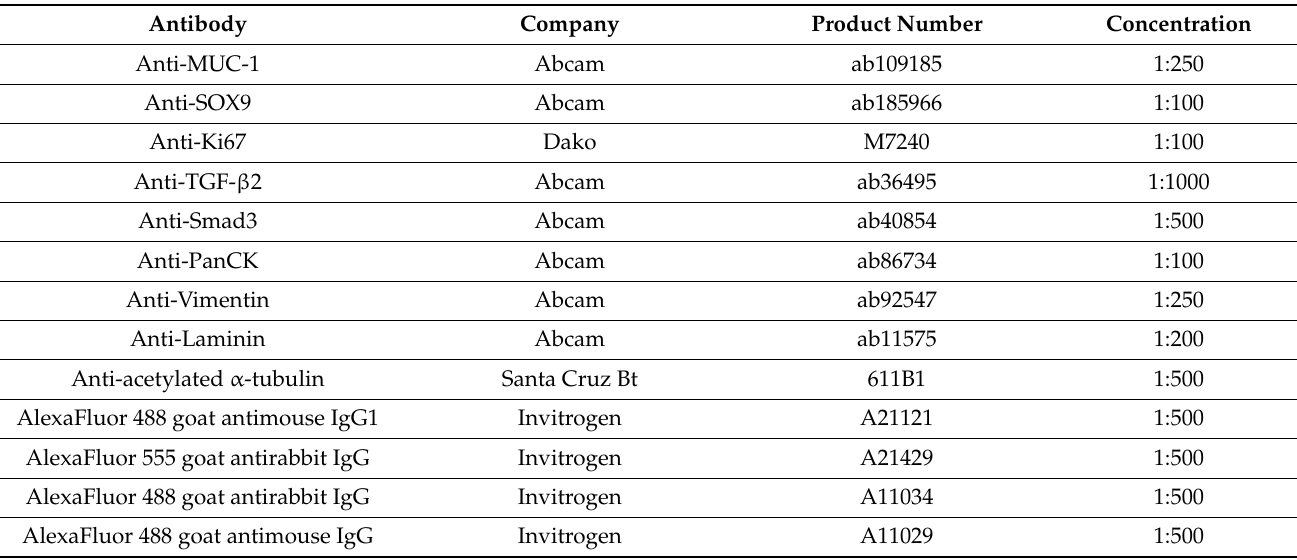
Table 2. Primary and secondary antibodies.